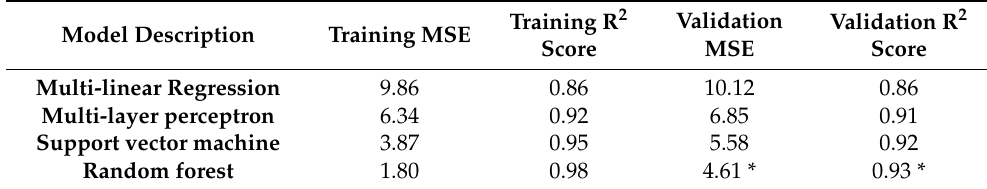
Table 5. Mean squared error (MSE) and R 2 score of four ML models for synthetic NPHI prediction. RF model achieved the least MSE and highest R 2 score on the validation data set highlighted in the table.